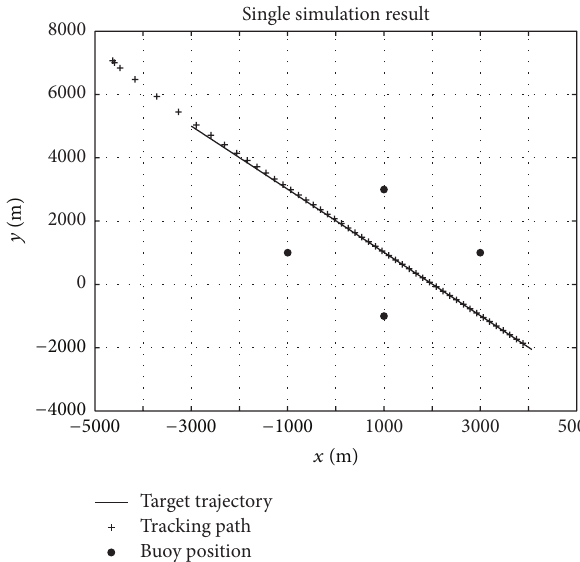
Figure 8: Schematic diagram of a single simulation tracking.